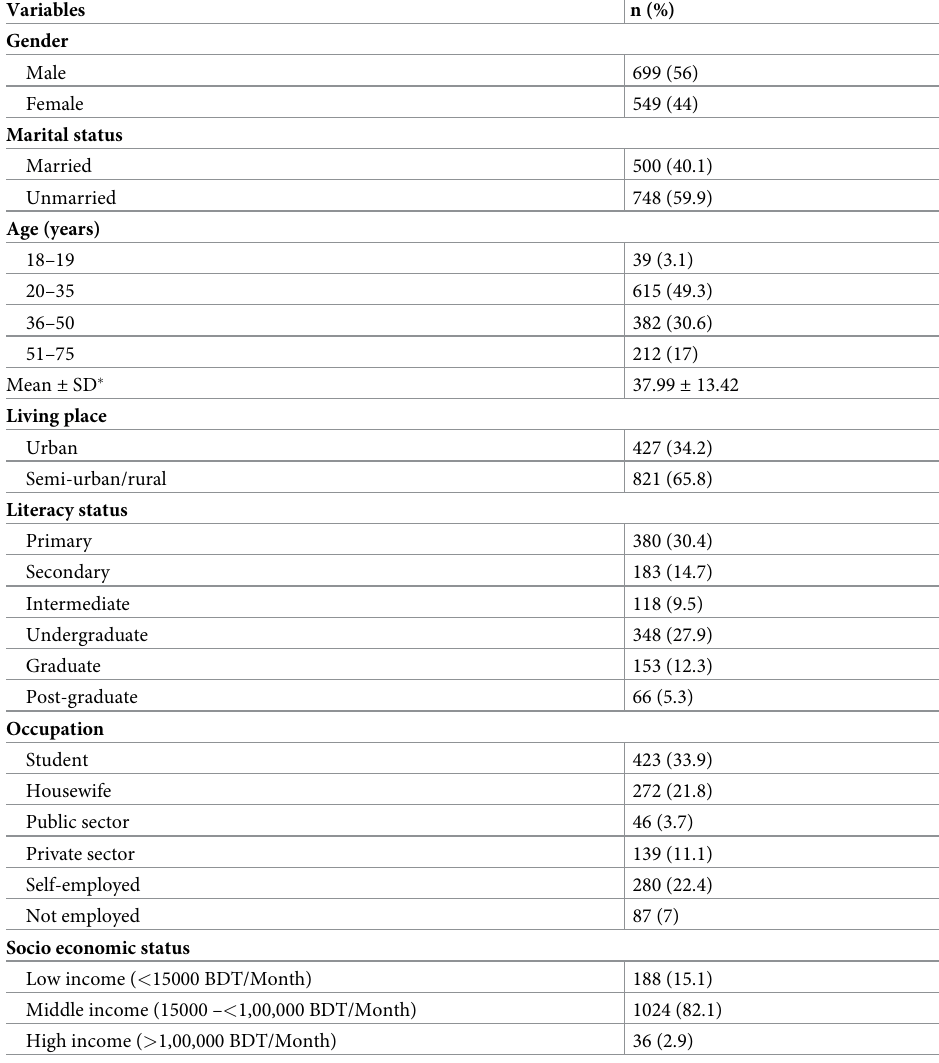
Table 1. Socio-demographic characteristics of respondents (n =